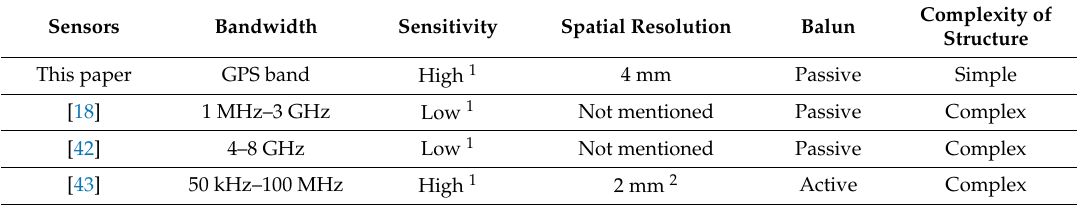
Table 3. Comparisons between the proposed tangential electric-field sensor and the others.